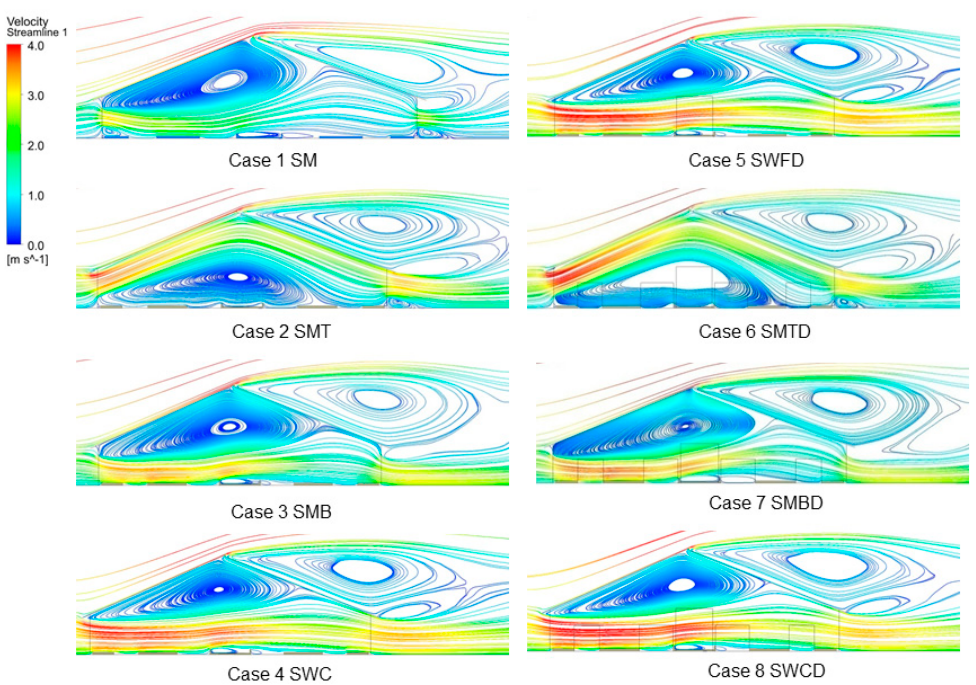
Figure 9. Airflow patterns inside and outside of the NVD barn for different opening combinations. The inlet velocity followed the profile described by Equation (1), and the reference profile velocity was 4.41 m ∙ s -1 at the height of 0.1 m.